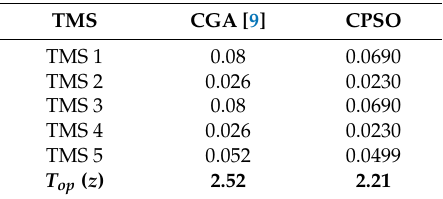
Figure 8. Convergence characteristic graph for Case II. Table 8. Comparison of the proposed method with the literature for Case II.